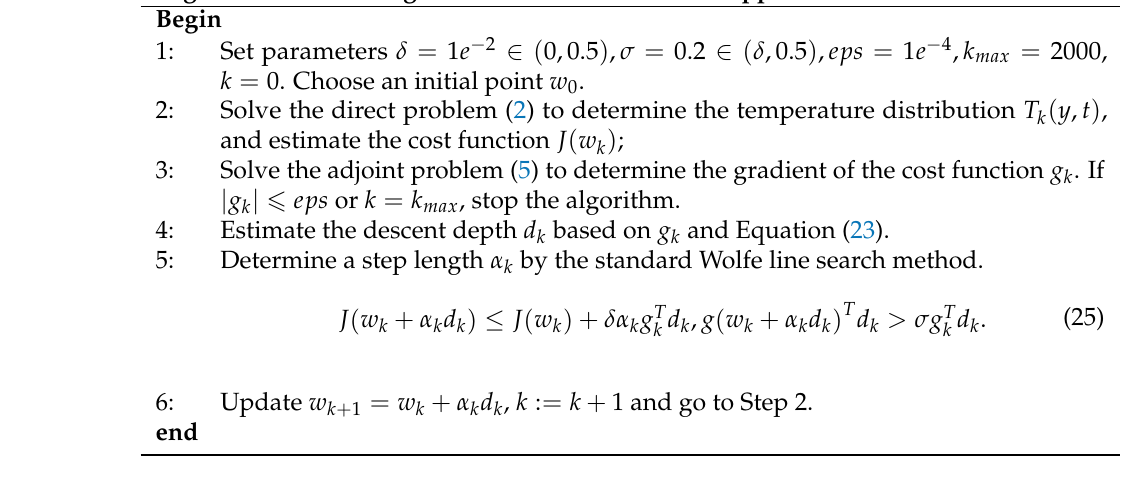
Algorithm 1: IHCG algorithm based on the FOTD